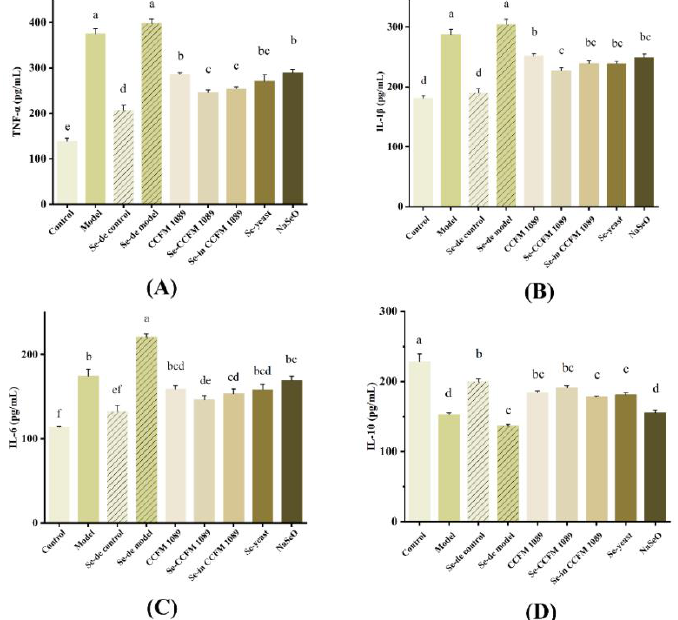
Figure 7. Effects of different Se products on interleukin concentration in colon. ( A )TNF- α levels ; ( B ) IL- 1β levels ; ( C ) IL-6 levels; ( D ) IL-10 levels. Graphs show mean ± SD; n = 5. Significant differences are indicated by different superscript letters ( p < 0.05), and the same superscript letters above the bars indicate that the differences between the values are not statistically significant ( p > 0.05).